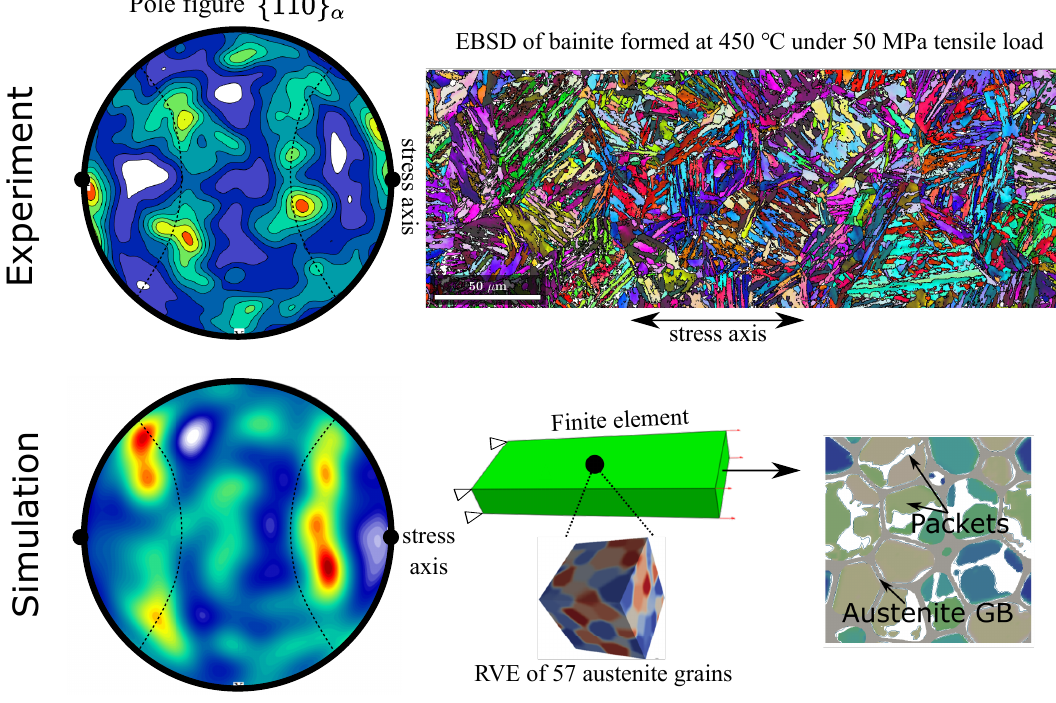
Figure 12. Simulated bainitic microstructure and texture with comparison to the experimental results; favorable alignment of the close-packed planes of bainitic ferrite grains can be observed in the pole